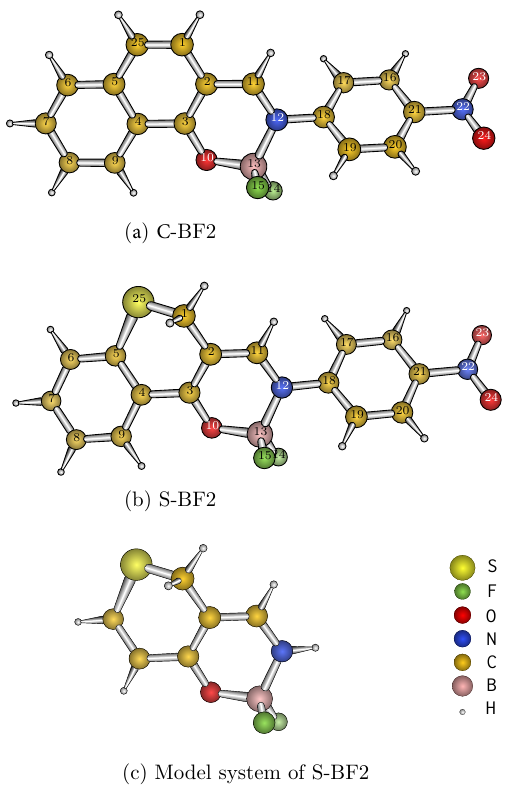
Figure 1. Structures of ( a ) C-BF2, ( b ) S-BF2, and ( c ) the model